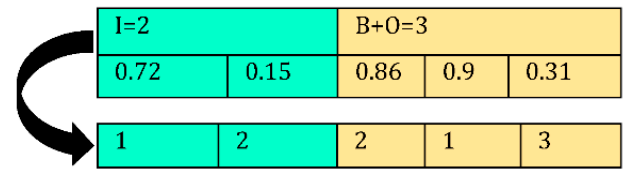
Figure 11. Sorting random